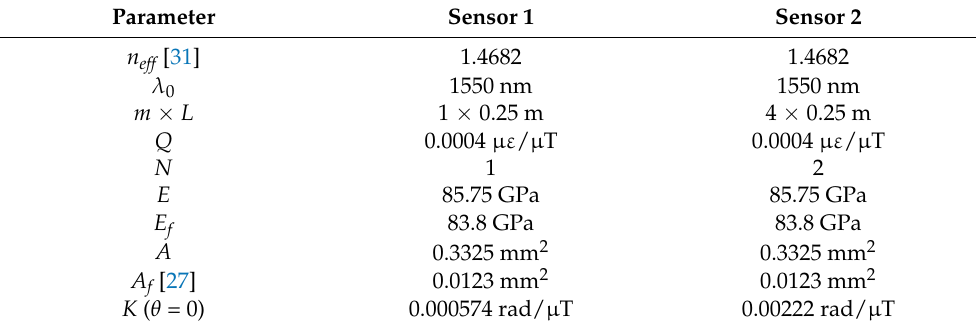
Table 1. Designed parameters.